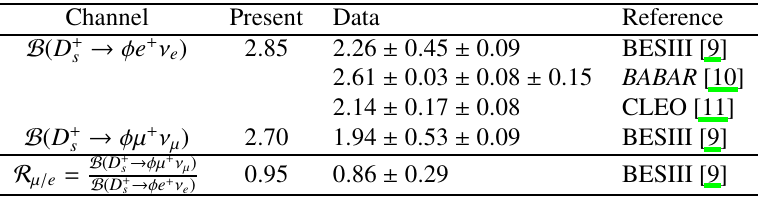
Table 3: Semileptonic branching fraction for D s meson (in